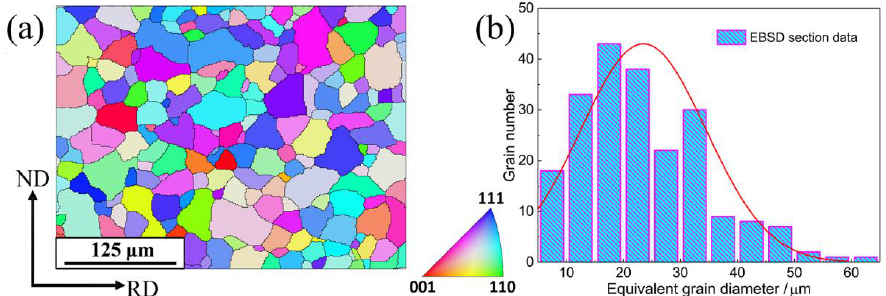
Figure 2. Initial microstructure of as-received NiTi SMA based on a EBSD (electron back-scattered diffraction) experiment: ( a ) EBSD scan area in Rolling-Normal (RD–ND) plane; ( b ) statistical analysis of equivalent grain diameter in the Rolling-Normal (RD–ND) plane.